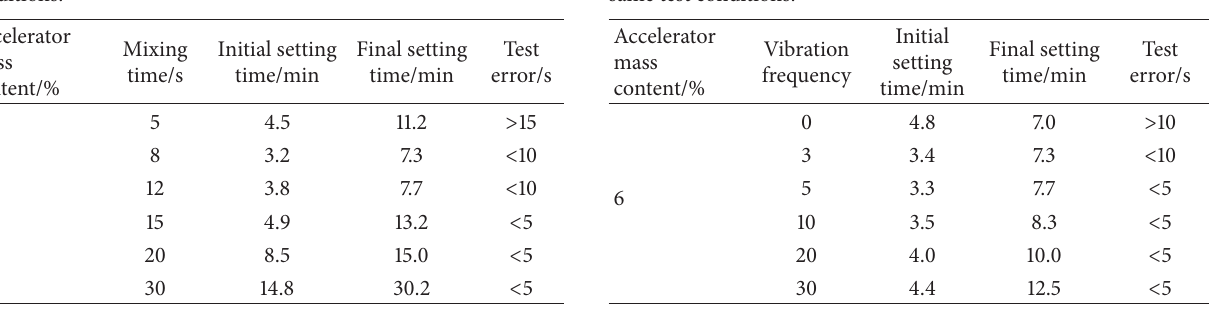
Table 3: Effects of mixing time on setting time under the same test conditions.